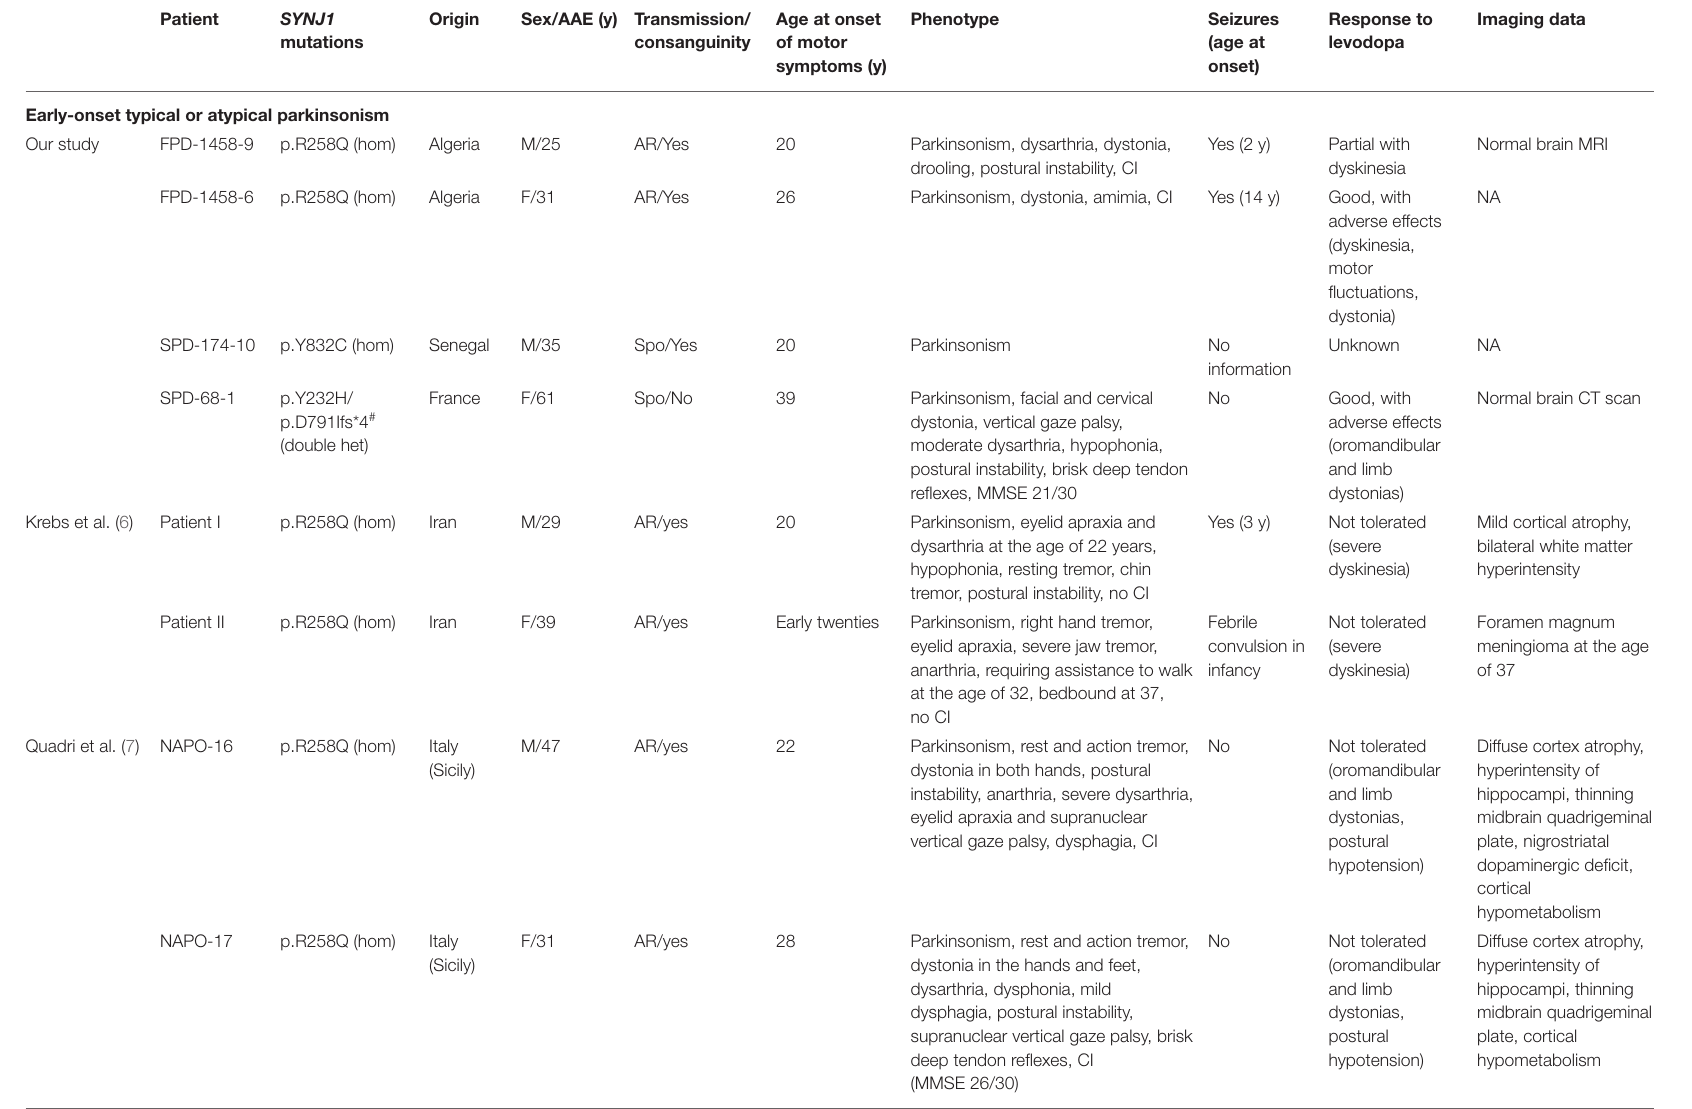
TABLE 1 | Clinical features of patients with biallelic mutations of the SYNJ1